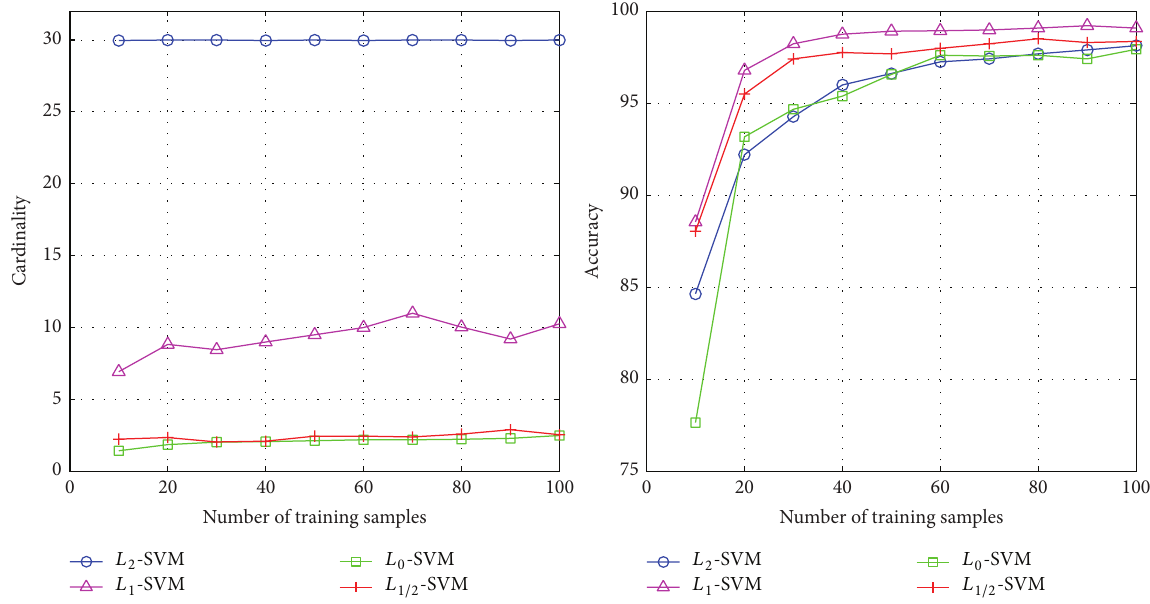
Figure 2: Results comparison on 10 artificial data sets with various training samples.